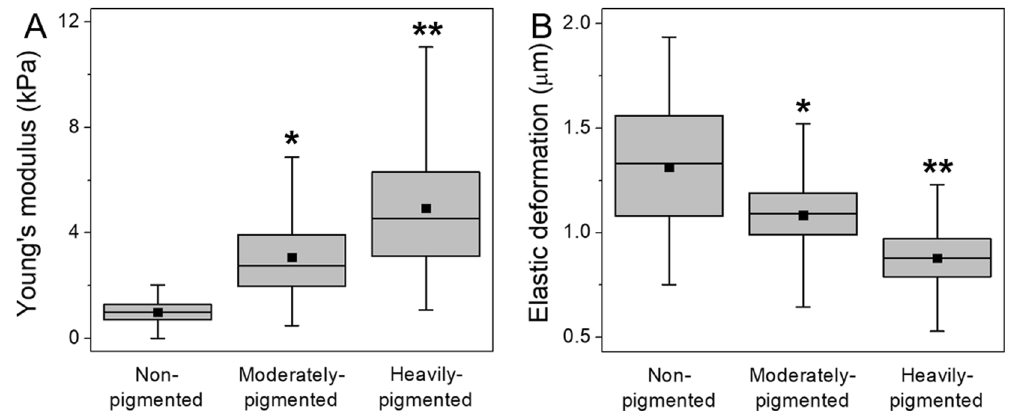
Figure 2. Nanomechanical properties of melanoma cells used in this study. Box plots of the Young’s modulus values ( A ) and of maximum elastic deformation ( B ) for melanoma cells with different levels of melanin pigmentation and for non-pigmented melanoma cells. Square dots in box plots indicate the median values, whereas horizontal lines represent means. * Statistically significant vs. non-pigmented cells; ** statistically significant vs. moderately-pigmented cells. For all values P < 0.0001.